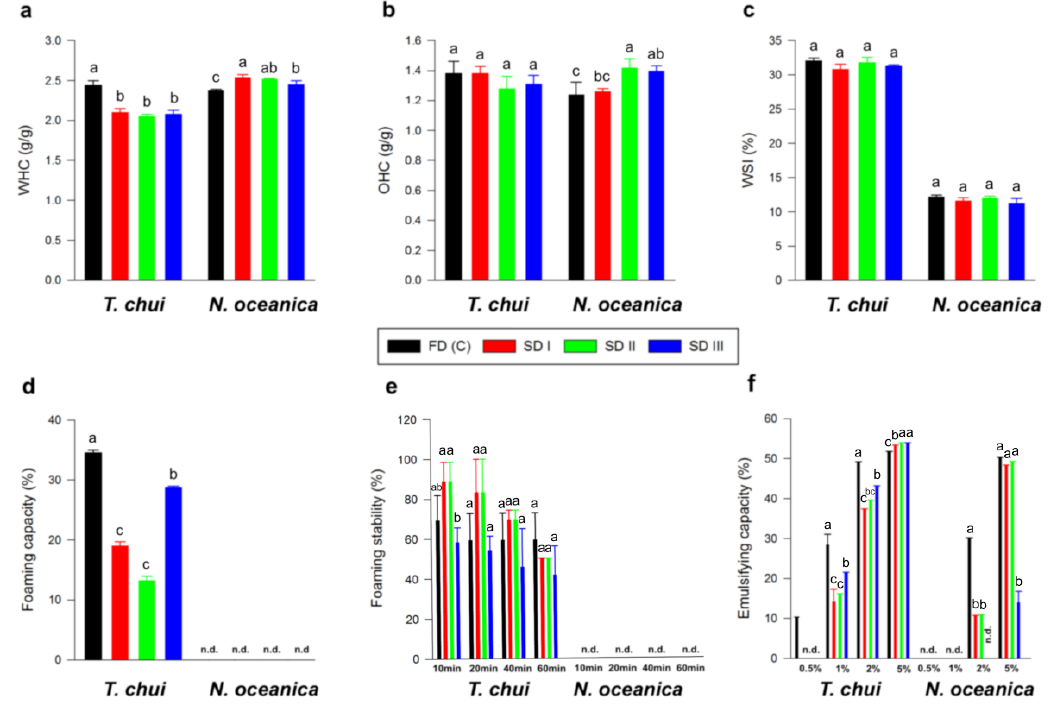
Figure 6. Water-holding capacity (WHC) ( a ), oil-holding capacity (OHC) ( b ), water solubility index (WSI) ( c ), foaming capacity ( d ), foaming stability ( e ), and emulsifying capacity ( f ) of solar- (SD I, II, and III) and freeze-dried (FDc) Tetraselmis chui and Nannochloropsis oceanica biomass. Different letters represent significant differences among samples from the same species detected by Tukey’s post hoc range test (HSD, ANOVA). Error bars represent standard deviation (Std Dev). Data points for solar- and freeze-dried samples are shown as mean ± Std Dev ( n = 3). N.d., not detected.